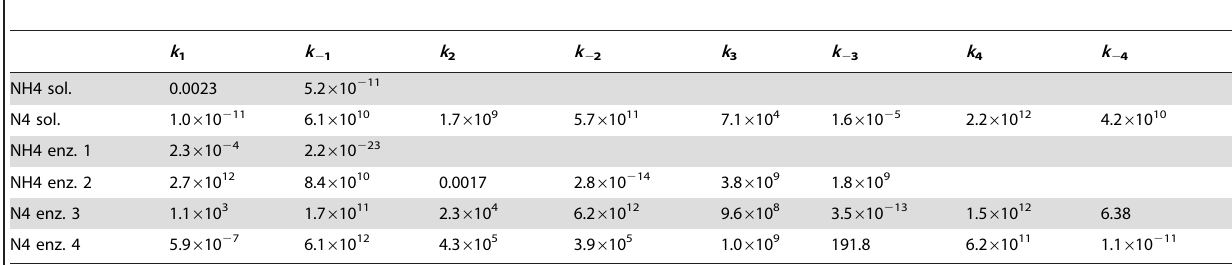
Table 2. Rate constants (s 2 1 ) for individual steps in the cyclization reaction of hydrolyzed biapenem in solution and in the configurations of the enzyme listed in Table 1